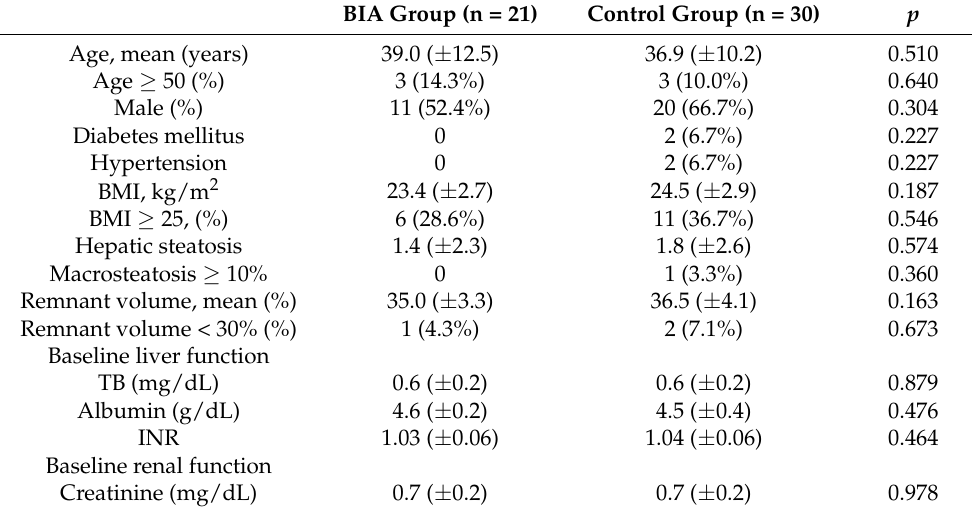
Table 1. Clinico-demographic characteristics of living